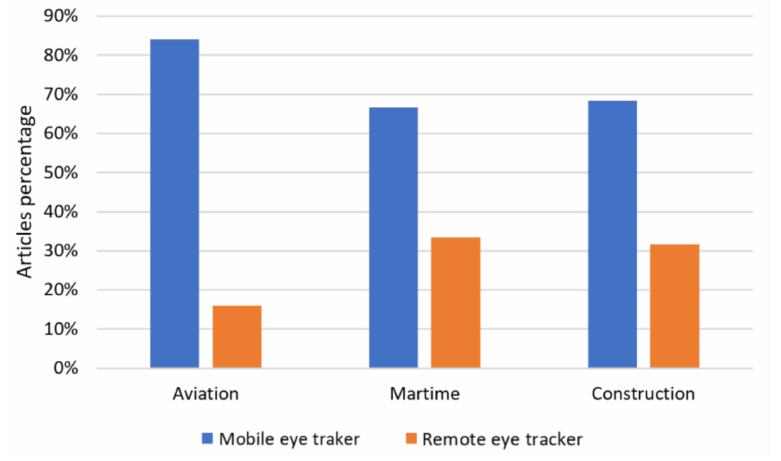
Figure 9. Preferred types of video-based eye tracking devices used in research for aviation, maritime, and construction